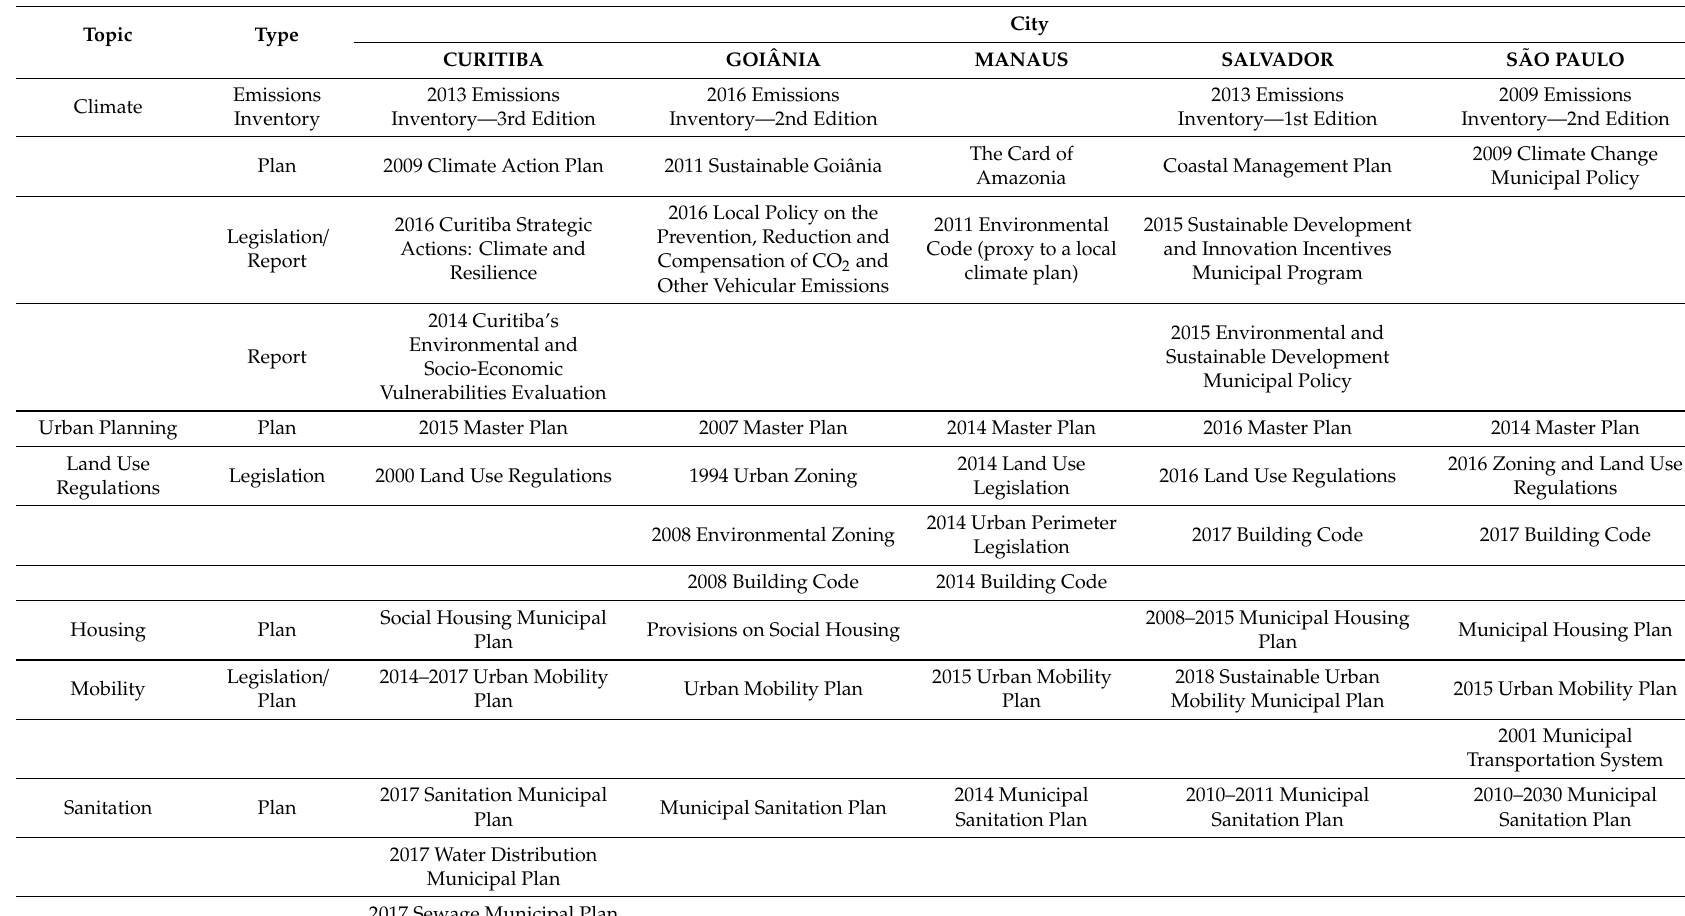
Table 3. Compiled policy documents organized by city and